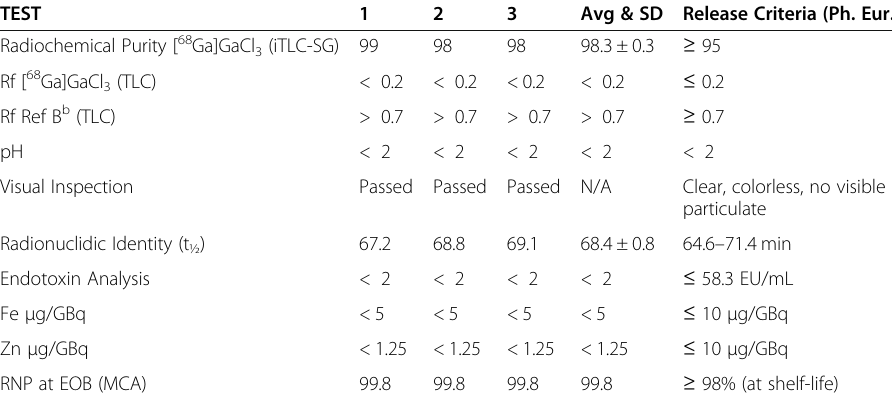
Table 7 Quality Control Data for three [ 68 Ga]GaCl 3 validation runs (UM) a TEST 1 2 3 Avg & SD Release Criteria (Ph. Eur.)